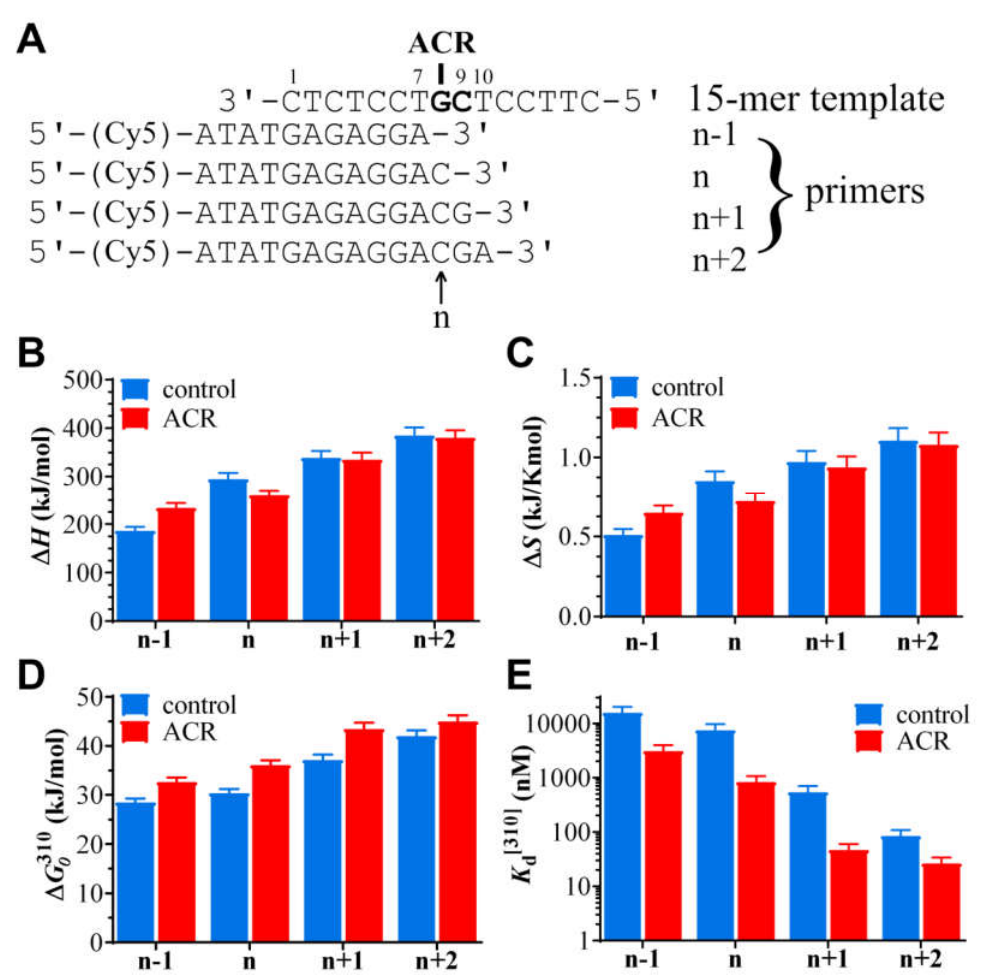
Figure 5. Simulated TLS: MST-derived thermodynamic parameters of dissociation of duplexes formed between the 15-mer DNA templates (unmodified, control duplex or the template platinated by ACR) and primers n – 1, n, n + 1, or n + 2. ( A ) Sequence pattern; Cy5 fluorophore is bound to the appropriate primer by the four-nucleotide linker. The GC in the template indicates the nucleobases of ACR platination (G) and intercalation of the acridine moiety (between G/C and the next C/G bp); n indicates the position of the ACR adduct in the template strand. ( B ) Diagram of enthalpy changes. ( C ) Diagram of entropy changes. ( D ) Diagram of the Gibbs free energy changes at 37 °C. ( E ) Diagram of changes of dissociation constants K d at 37 °C.